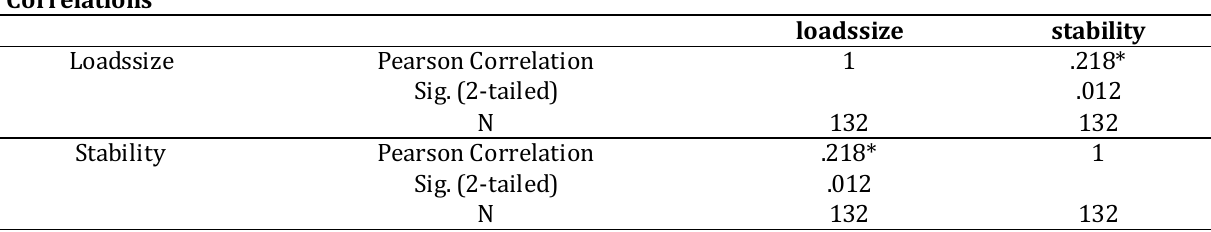
Table 6: Above load line loading and stability Correlations Loadssize Pearson Correlation Stability Pearson